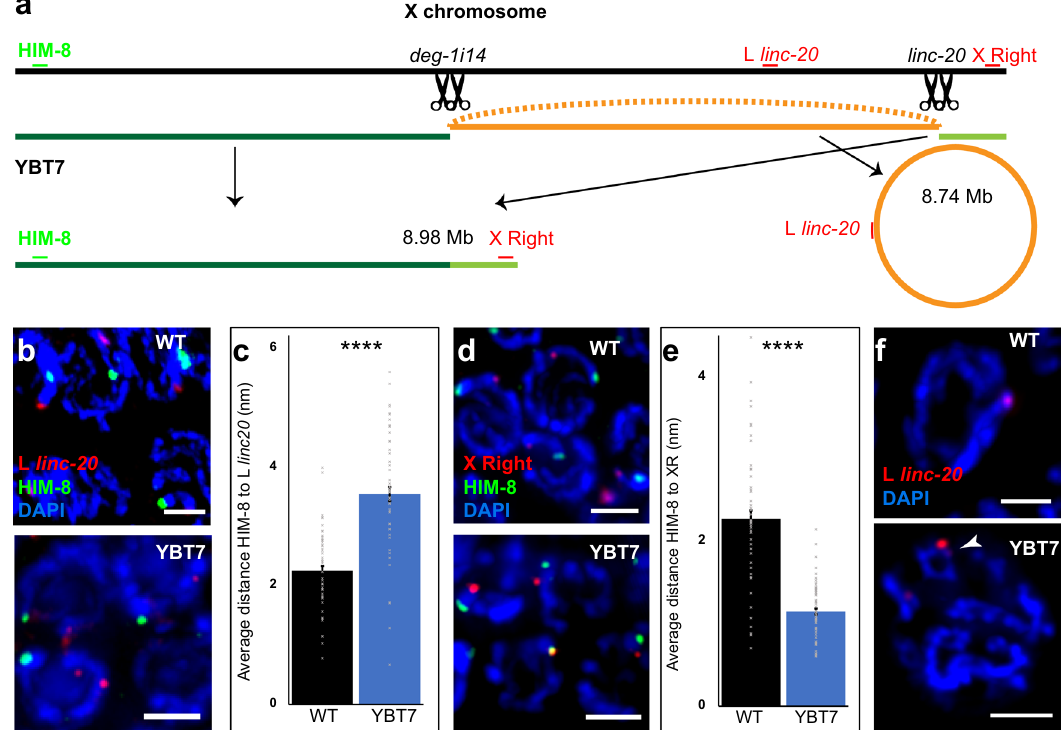
Fig. 1 Engineering of worm strains with bisected X chromosomes. a Illustration of the X chromosome in a wild-type worm and the segments resulting from Cas9-mediated cleavage during generation of YBT7 worms. The gRNA binding sites (black scissors) and cytological markers (green and red) used in analyses of X chromosome segmentation are indicated. b Pachytene nuclei stained with DAPI (blue), anti-HIM-8 (green), and FISH probe complementary to a site to the left of linc-20 (red). c Averages ± SEM of the distance between HIM-8 and the site left of linc-20 . d Pachytene nuclei stained with DAPI (blue), anti-HIM-8 (green), and FISH probe complementary to the right end of the X chromosome (red). e Averages ± SEM of the distance between HIM-8 and the site on the right end of chromosome X. f Late pachytene nuclei stained with DAPI (blue) and the FISH probe complementary to the site left of linc- 20 (red). The FISH signal associated with the internal segment is marked with an arrowhead. n = 80 nuclei. **** p < 0.0001, by the two-tailed Mann – Whitney test. Scale bars = 3 μ